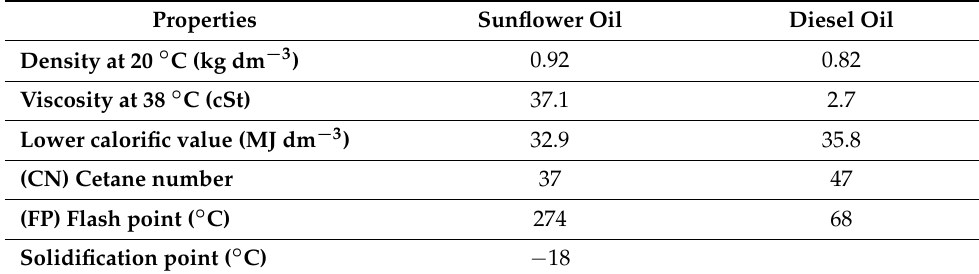
Table 5. Main properties of sunflower oil and diesel. (Source: CTI,